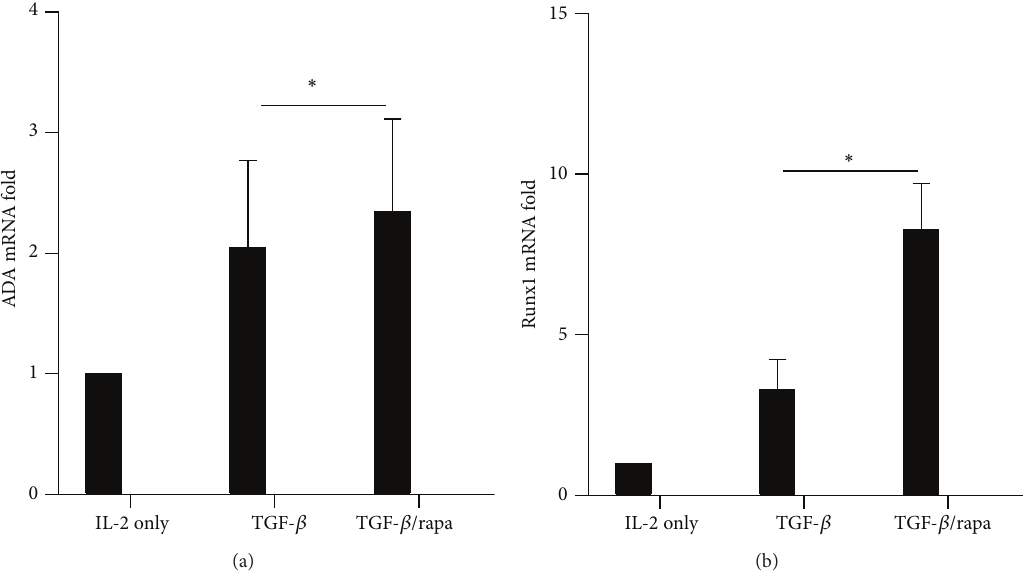
Figure 4: Rapamycin upregulated the mRNA level of ADA and Runx1 in Treg cells. The expression of (a) ADA mRNA and (b) Runx1 mRNA was determined by RT-PCR. Gene expression levels from the IL-2 group were set at 1. The values indicated the mean ± SEM of 3 separate experiments. ∗ 𝑃 < 0.05